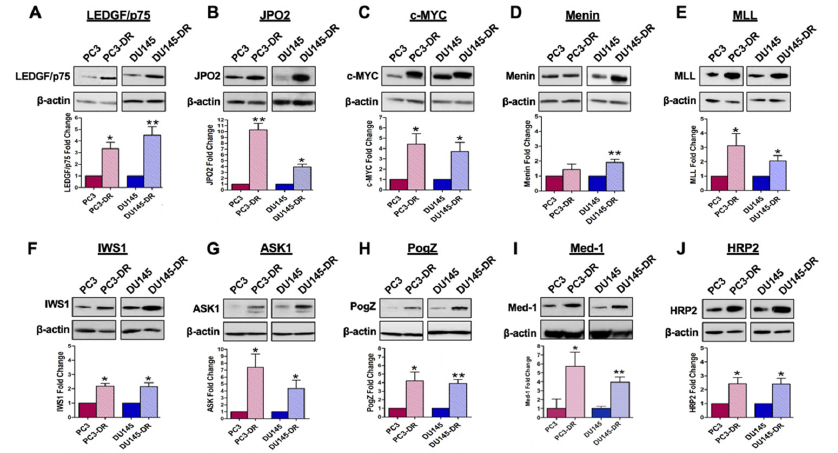
Figure 1. LEDGF/p75 and its IBD-interacting partners are differentially upregulated in DTX-resistant PCa cell lines. Upper panels: immunoblots showing upregulation of ( A ) LEDGF/p75, ( B ) JPO2, ( C ) c-MYC, ( D ) menin, ( E ) MLL, ( F ) IWS1, ( G ) ASK1, ( H ) PogZ, ( I ) Med-1, and ( J ) HRP2 in DTX- resistant PC3-DR and DU145-DR cells compared to their parental, drug-sensitive counterparts. Bottom panels: bar graphs showing quantification of fold change in protein expression from at least three independent experiments per cell line via densitometric ImageJ analysis, with values normalized to β -actin. Paired t -test statistical analysis revealed that protein expression in DTX- resistant PCa cells achieved statistical significance compared to controls (* p < 0.05, ** p < 0.01). Due to the very low expression of some of the proteins in the parental PC3 and DU145 cells, we normalized their expression to an arbitrary value of 0.10 for quantification purposes. Error bars represent mean ± standard deviation